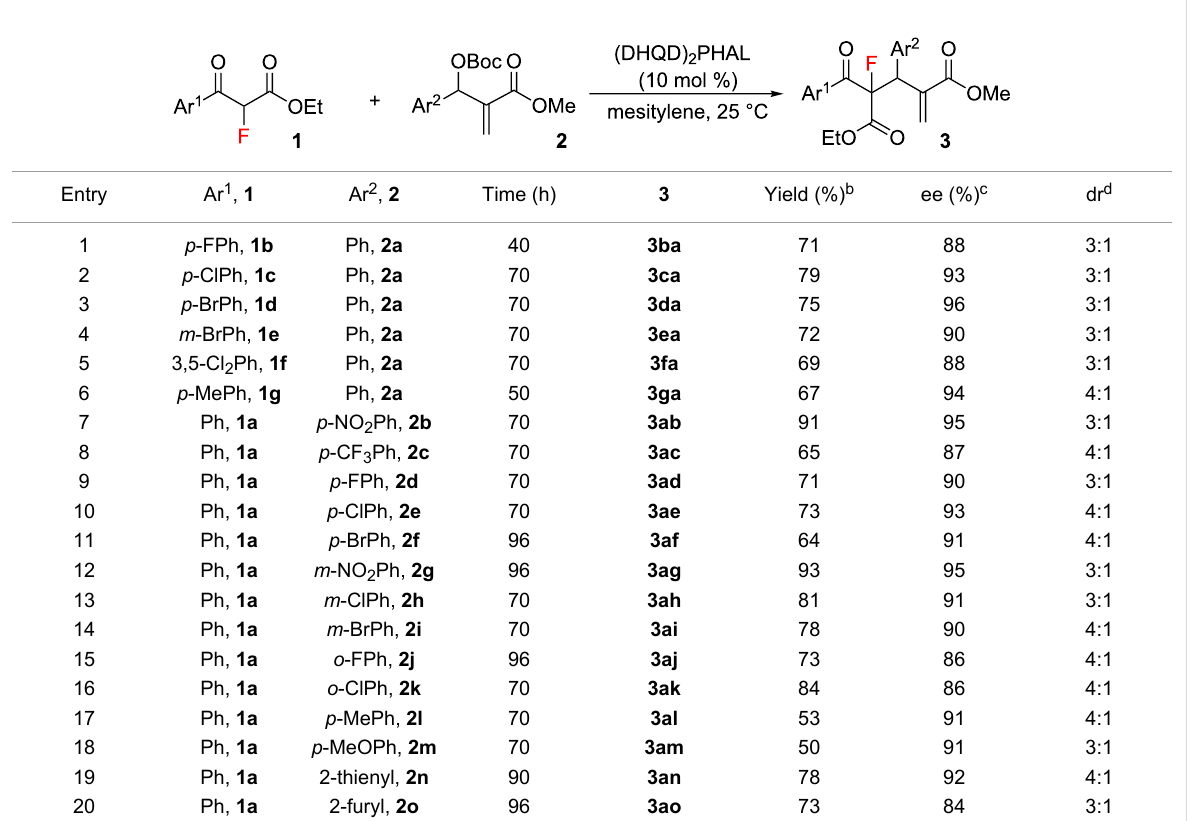
Table 2: Allylic alkylation of α -fluoro- β -ketoesters 1 with MBH carbonates 2 a .